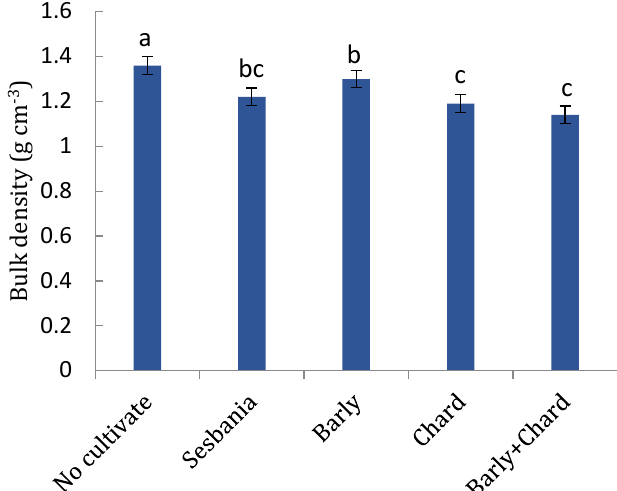
Figu re 2. Phytomanageme nt effe ct on the soil bu lk density (g cm -3 ) of th e surfac e laye r (0-30cm ) afte r three seasons. Values rep resen t mean ± S D.